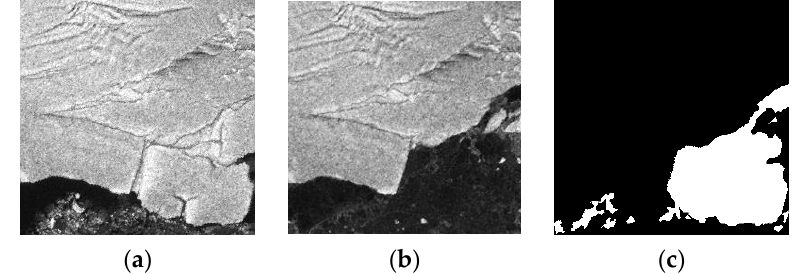
Figure 6. Sulzberger dataset. ( a ) Image acquired on 11 March 2011; ( b ) image acquired on 16 March 2011; ( c ) ground truth.